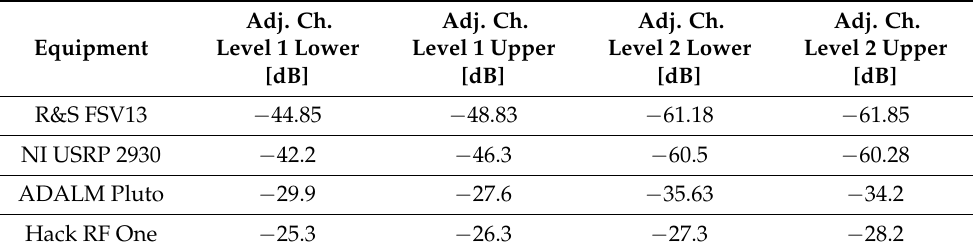
Table 3. Attenuation of adjacent channels by the three types of SDR platforms and for the R&S FSV13 spectrum analyzer (TETRA channel no. 131, input level − 62 dBm).